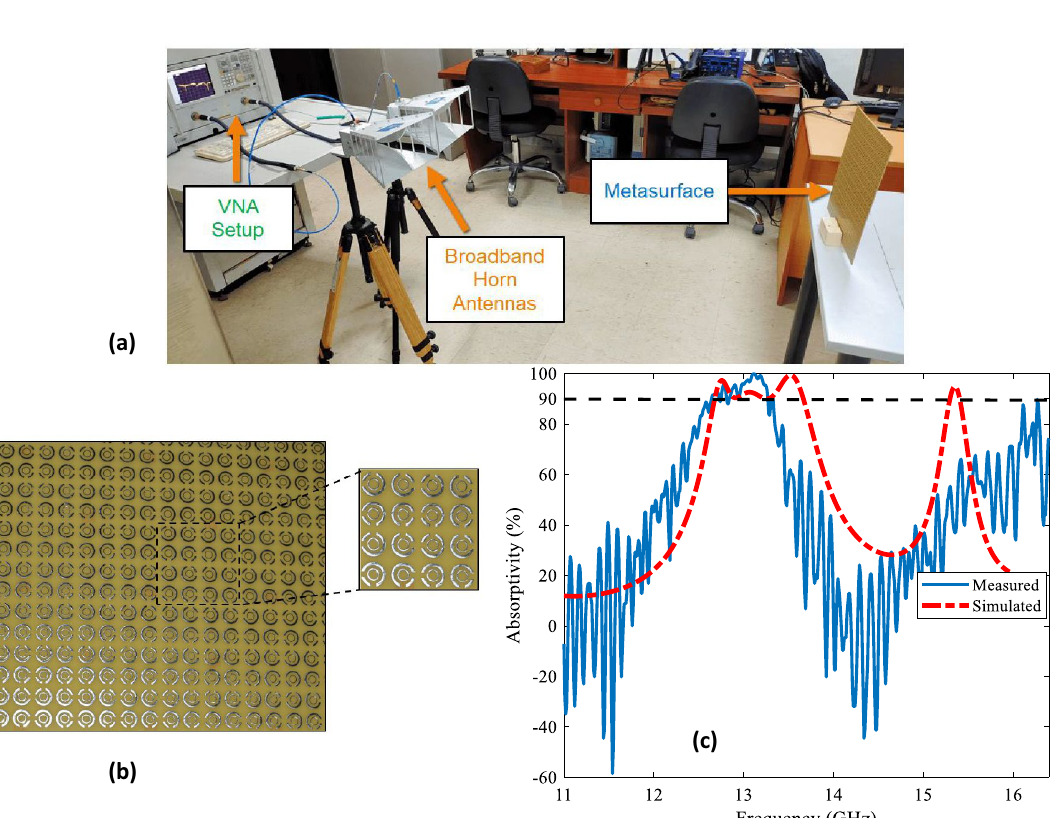
Figure 8. ( a ) Experimental setup for the measurement of co-polarized reflection component R xx . For cross polarized reflection component, the receiving horn antenna is rotated by 90°. ( b ) The fabricated prototype of the proposed metasurface absorber. ( c ) A comparison between measured and simulated absorptivity spectrum for the anti-reflecting metasurface